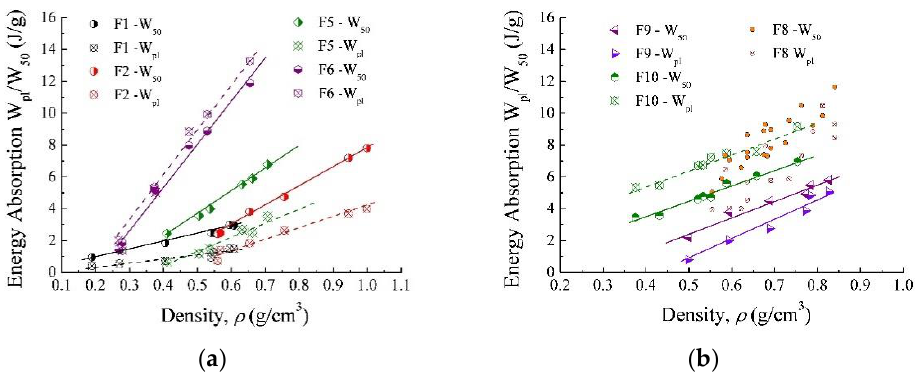
Figure 3. Energy absorption W pl / W 50 vs. density for the foams processed with TiH 2 (F1, F5, F9) and those produced with CaCO 3 (F2, F6, F8, F10), which are performed with various alloys, such as ( a ) Al (F1, F2), Al-Mg-Si (F5, F6) and ( b ) Al-Zn-Mg (Sc,Zr) (F8), Al-Zn-Mg (F9, F10).